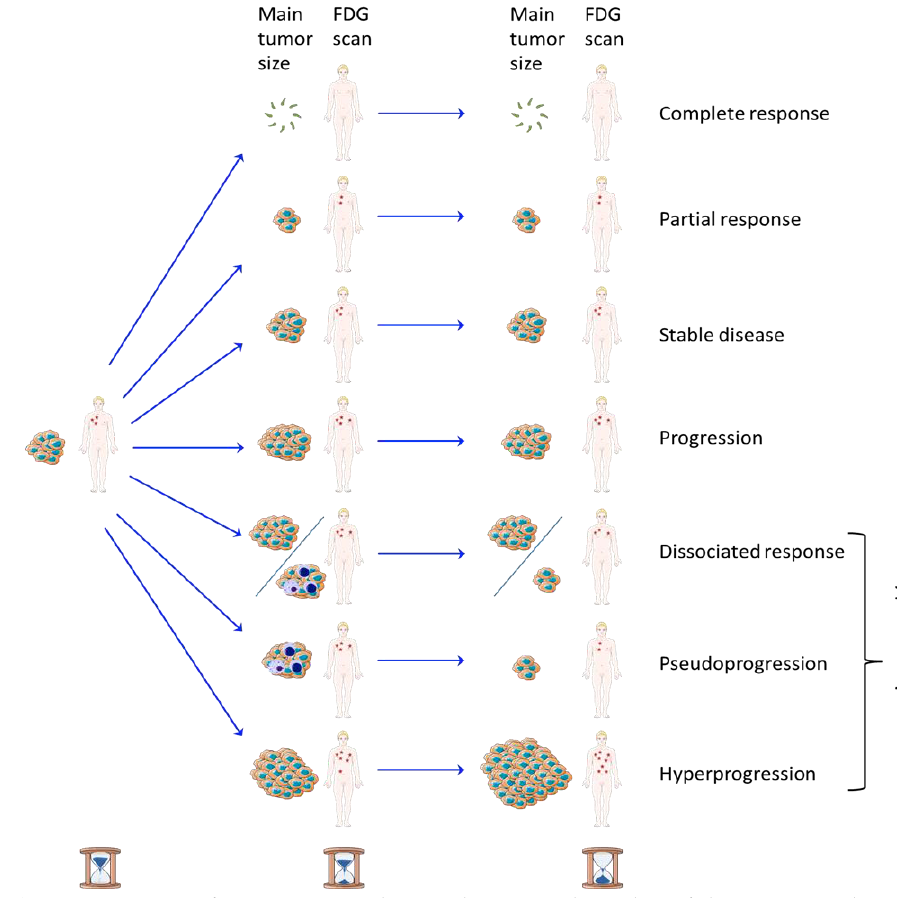
Figure 3. Patterns of response according to the size and number of the tumors and in function of time of examination. Complete response, partial response, stable disease, and progression are the four classical patterns of response in oncology. Concerning the atypical responses sometimes observed with immune-checkpoint inhibitors, a dissociated response corresponds to lesions shrinking and others growing; pseudoprogression is an initial increase in tumor size and/or number due to inflammation followed by a decrease, and hyperprogression is an accelerated tumor growth rate after starting treating.